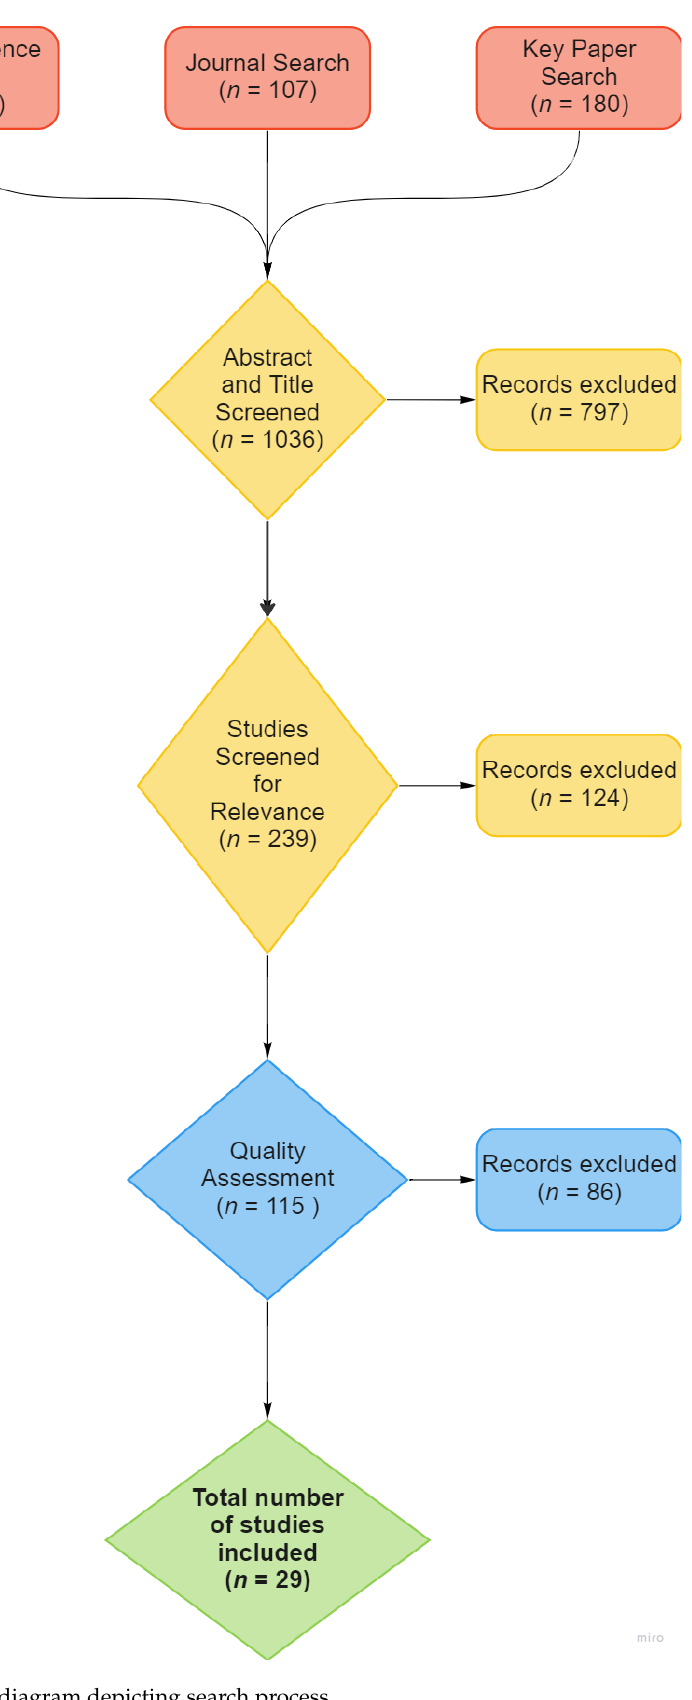
Figure 1. Flow diagram depicting search process.